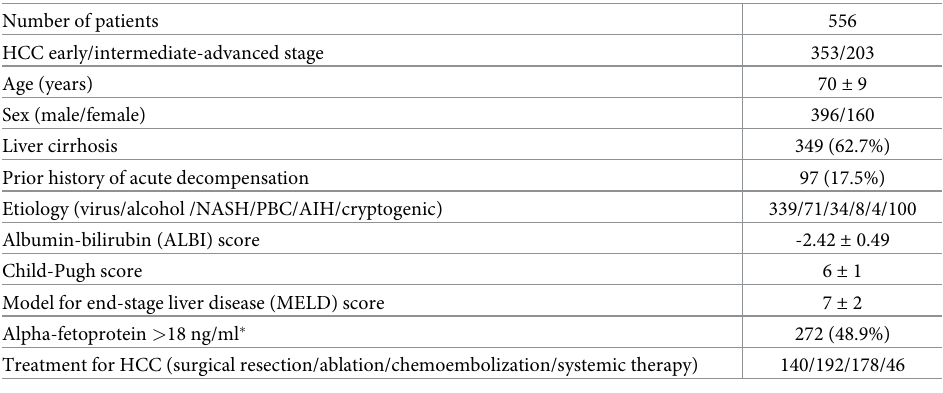
Table 1. Patient